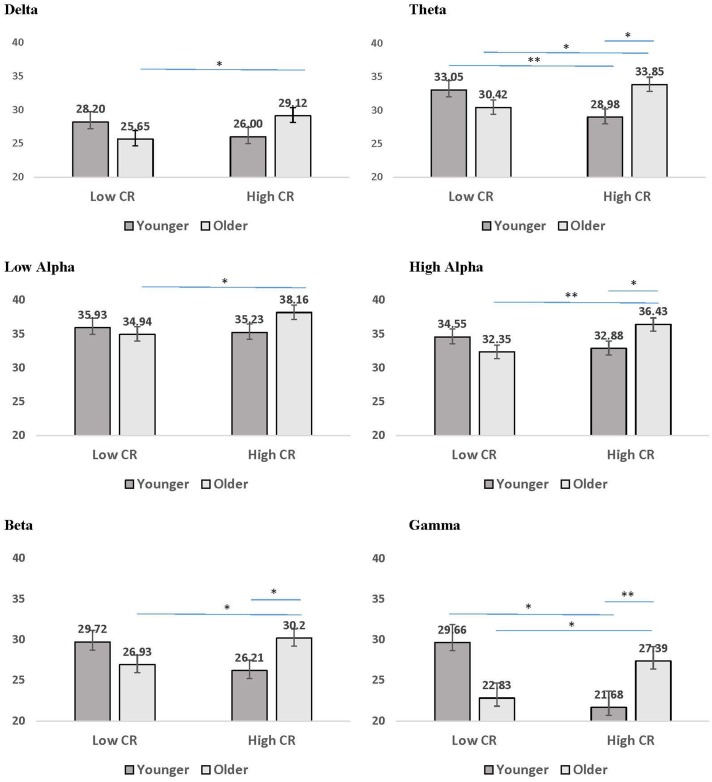
Mean coherence for younger (dark gray bars) and older (light gray bars) participants in low CR versus high CR conditions. Error bars reflect the standard error for each condition. Lines connect conditions that differ significantly from each other, with the endpoints of each line over the middle of the bars for conditions that differ significantly from each other during pairwise comparisons. ∗p < 0.05, ∗∗p < 0.01, ∗∗∗p < 0.001.